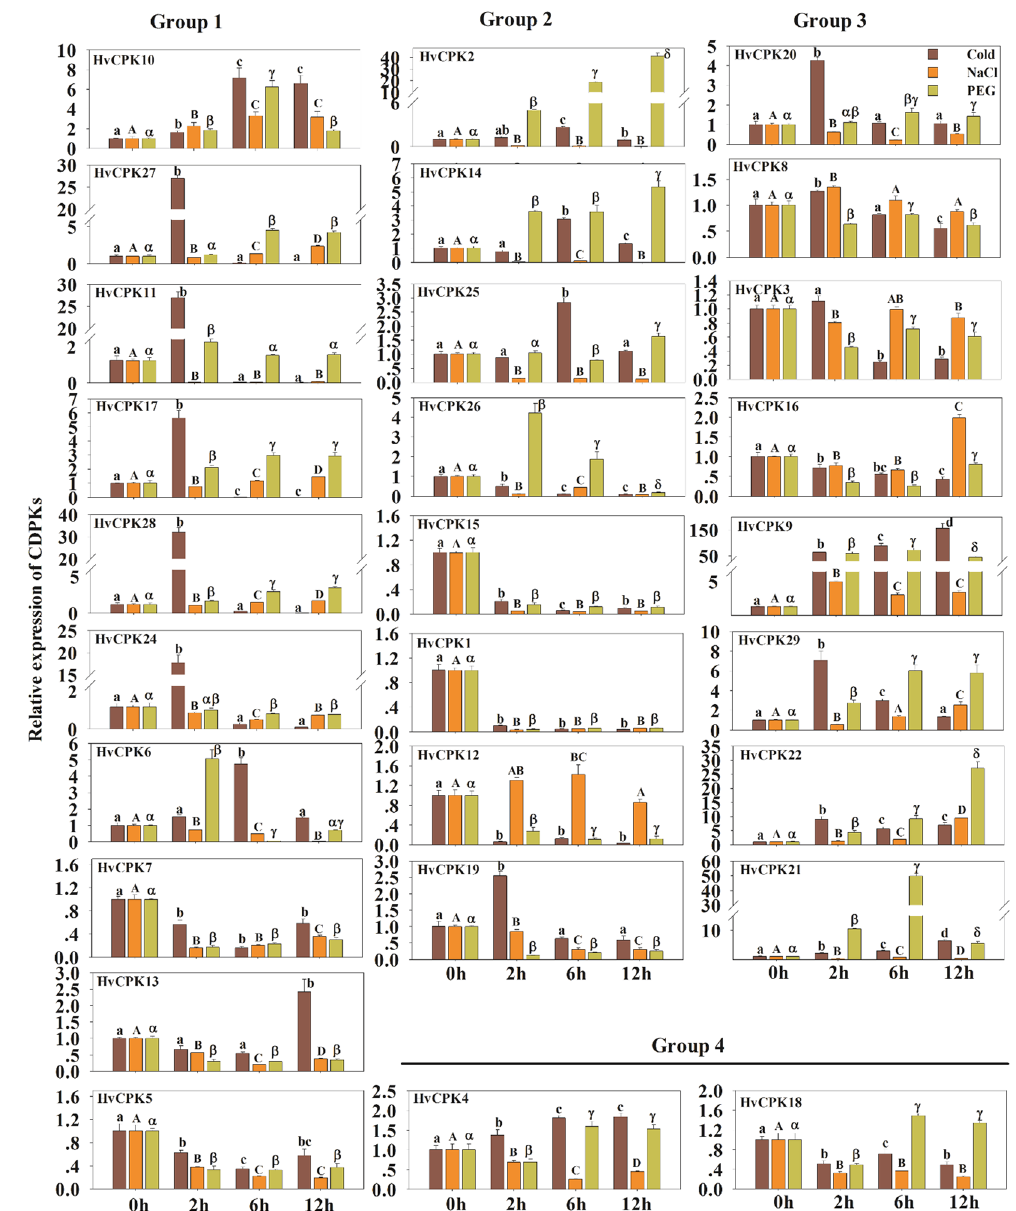
Figure 5. Expression profiles of the HvCDPK genes under cold, salt and PEG stress conditions. Data are mean values ± SE obtained from three replicates. Different letters within a column indicate a significant difference (P < 0.05; Tukey’s